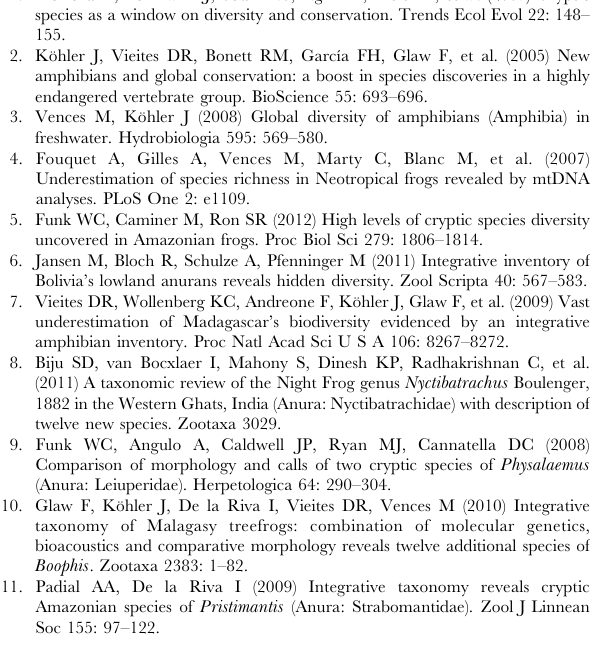
Table S3 Uncorrected pairwise p -distance among line- ages and average within lineage p -distance. Table S4 List of primers used in this study with respective anealing temperatures. Table S5 Localities and coordinates used in the Spatial Distribution